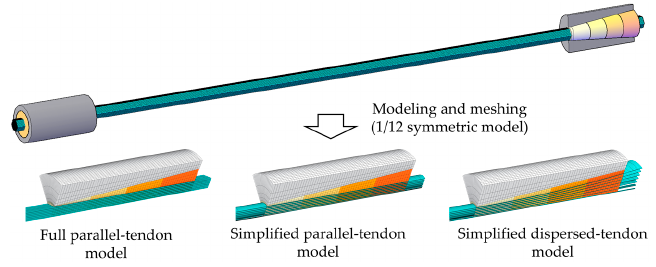
Figure 7. Full and simplified FE models.